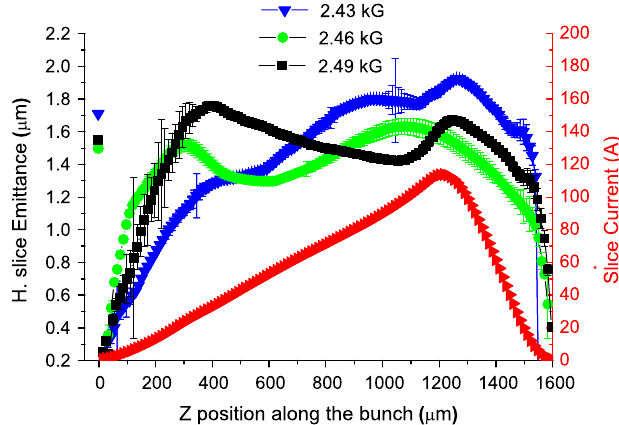
FIG. 10. Slice emittance comparison for different gun solenoid strengths, and compression factor of 3. The points at z ¼ 0 show the horizontal projected emittances reconstructed from the slice